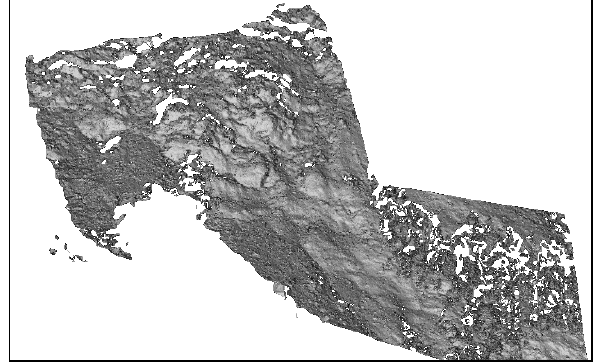
Figure 5: The DSM of the slope acquired on July 23 rd at 1